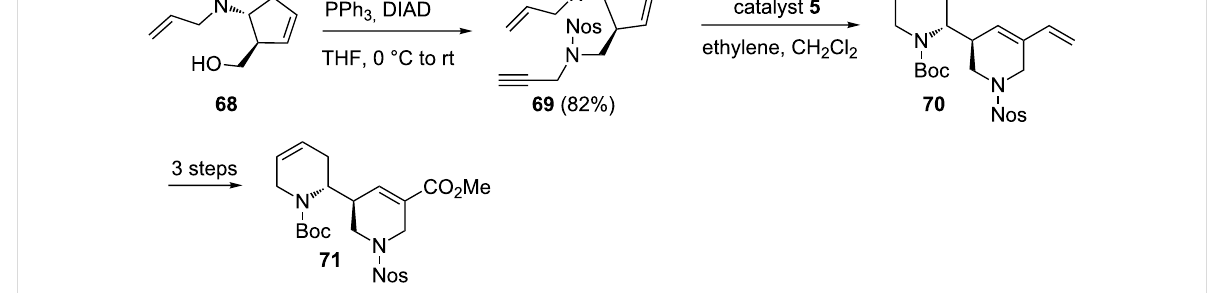
Scheme 12: RRM protocol to dipiperidine system.